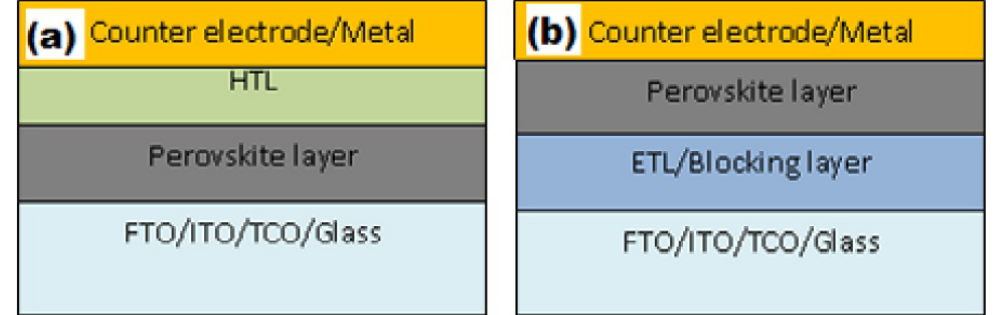
Fig. 9. (a) ETL free PSC (b) HTL free